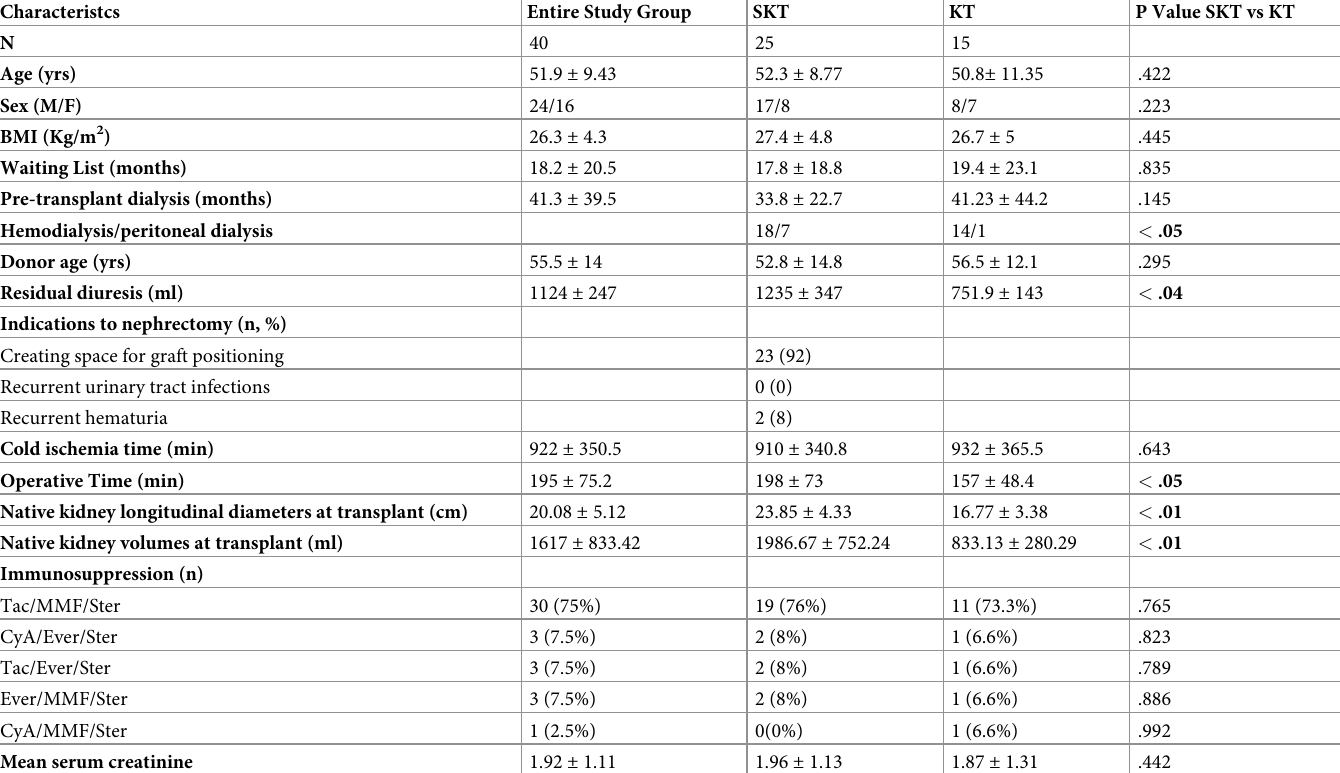
Table 1. Clinical data of 40 patients kidney transplant recipients. Patients of group SKT (25 patients) were compared with group KT(15